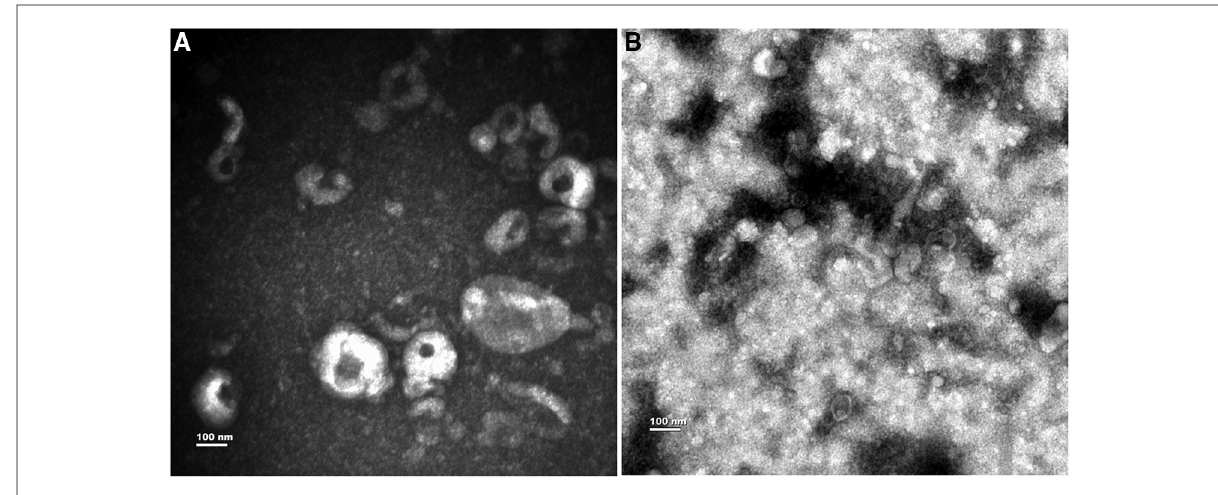
FIGURE 1 Characterization of exosomes from PE. ( A ) The exosomes from MPE. ( B ) The exosomes from TPE.